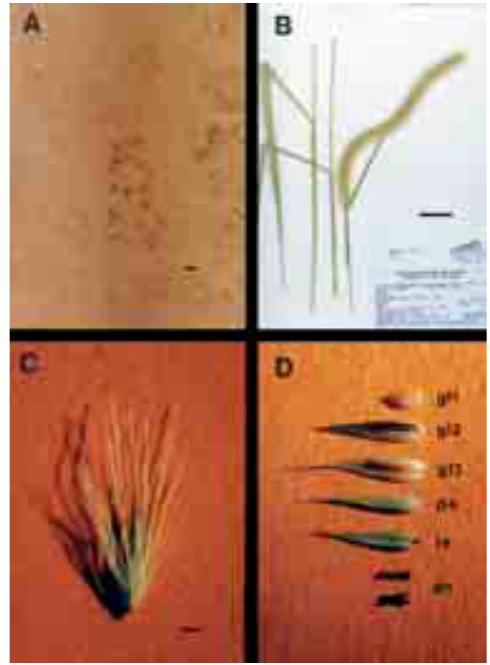
Figure 3 - BAG Hexaploid 204. A. Mitotic metaphase with 2n = 42 chro- mosomes; B. Specimens; C. Spikelet; D. Constituent of the spikelet: an (anthers), le (lemma), pa (palea), gl3 (3 rd glume), gl2 (2 nd glume), gl1 (1 st glume). The bars represent: A. 5 µ m; B. 5.6 cm; C and D. 2.3 mm. UFLA. Lavras, MG, Brazil, 1998.